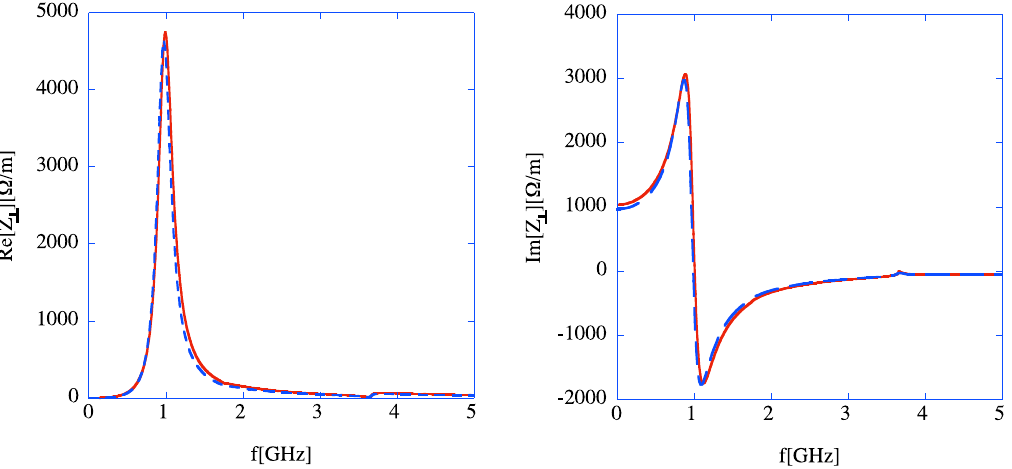
FIG. 7. (Color) Comparison of the real (left) and imaginary (right) parts of the transverse impedance, calculated by the present theory (red curves) and ABCI (blue curves), respectively. We used the same parameters as the longitudinal case. Namely, (cid:6) (cid:4) 1000 , a (cid:4) 5 cm , w (cid:4) 4 mm , and z (cid:4) 0 m . The large resonance peak can be noticed at 1 GHz, which corresponds to the frequency where the wavelength is equal to the chamber